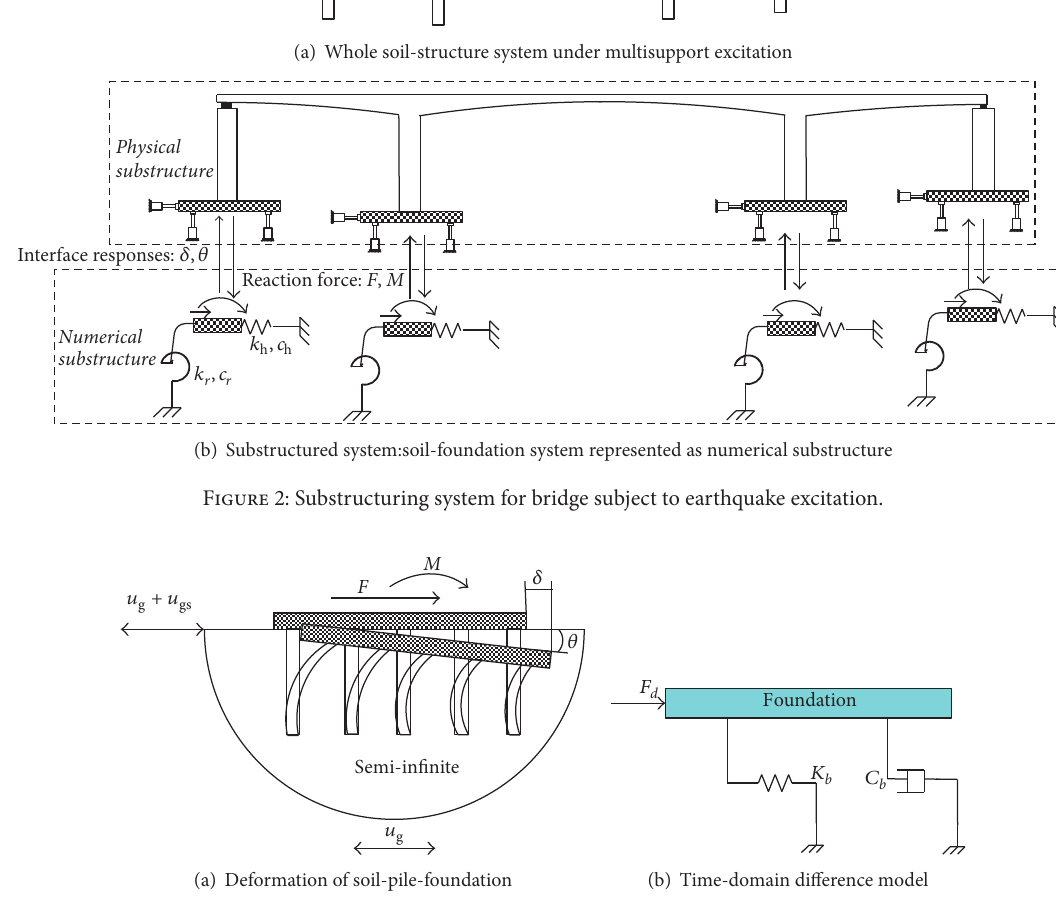
Figure 3: Numerical model of soil-pile-foundation